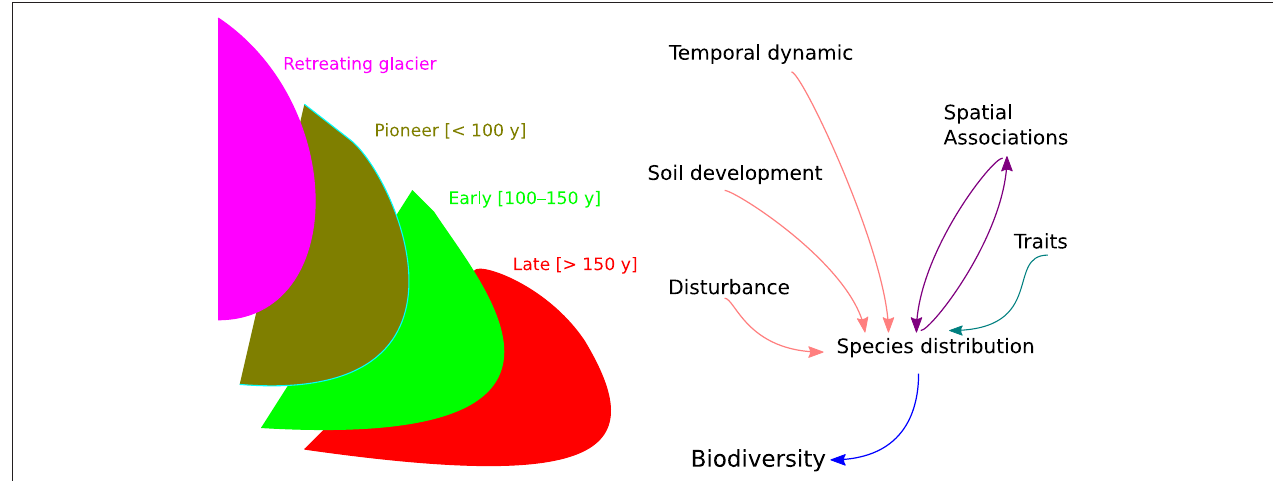
FIGURE 1 | On the left, schematic representation of glacier retreat dynamic, with “pioneer” (dark green), “early” (light green), and “late” (red) stages of ecosystem development. On the right, framework of the hierarchical joint species distribution modeling for forecasting biodiversity change.